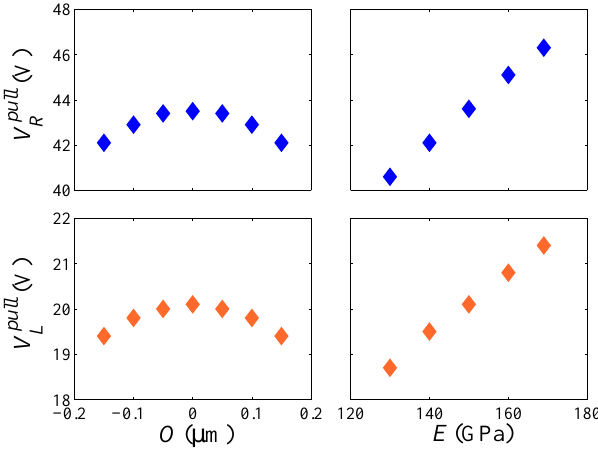
and V pull to a variation of ( left ) over-etch O or R L